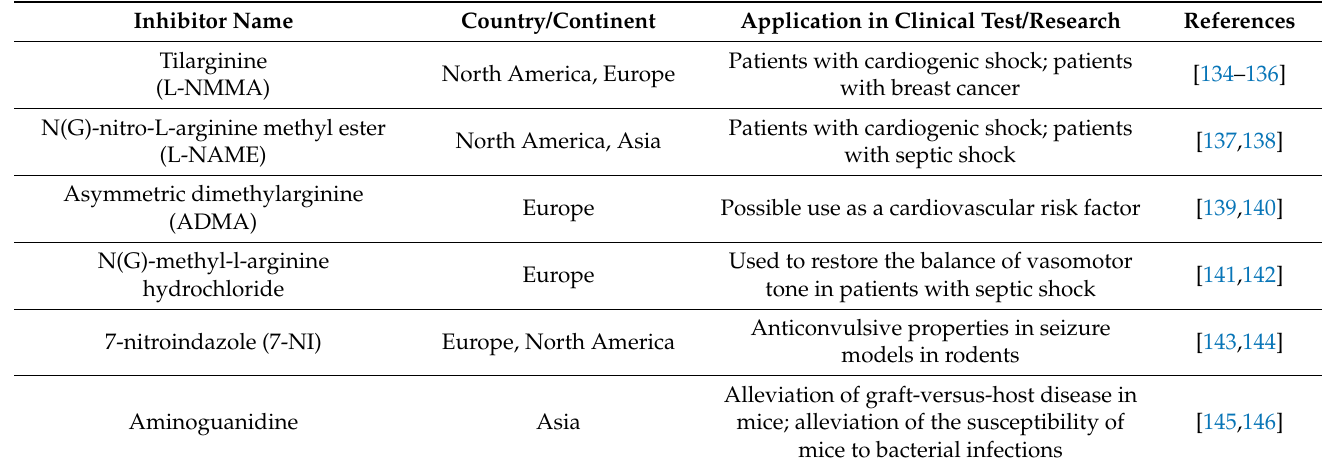
Table 3. NOS inhibitors and research conducted on them